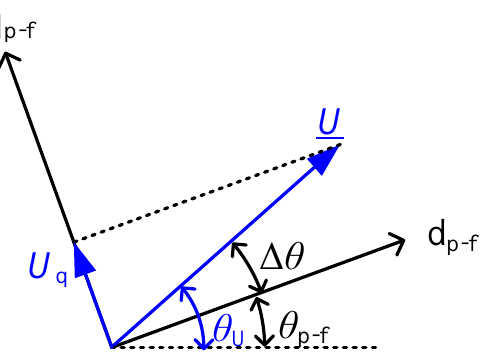
Figure 13. The terminal voltage vector U in the synchronous rotation coordinates of the P-f loop.